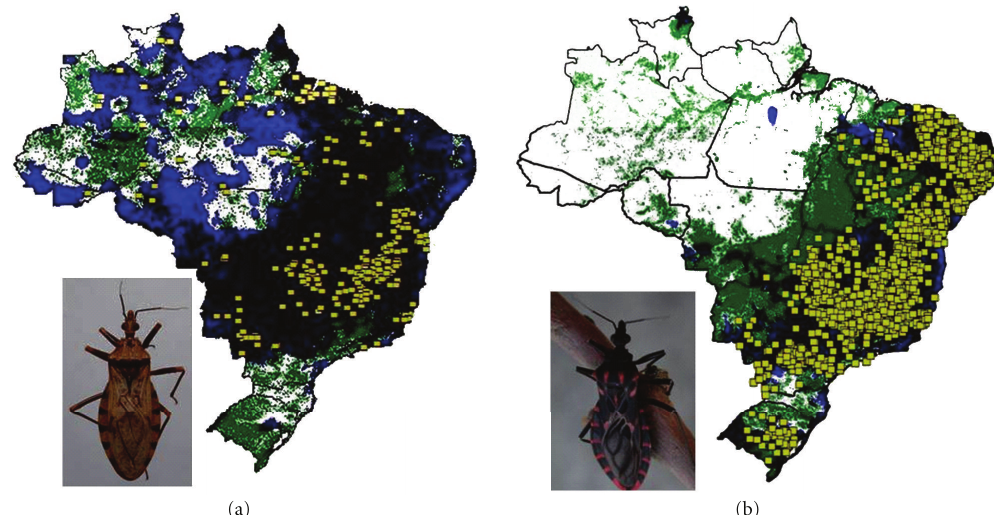
Figure 2: Ecological niche models projected as potential distributions for triatomine species with widespread distribution in Brazil. (a) Panstrongylus geniculatus and (b) P. megistus . Known occurrences of the species are shown as yellow squares, and the final consensus prediction is shown as black shading. Areas identified as suitable based on climatic grounds only are shown in blue, whereas areas identified as suitable based on normalized di ff erence vegetation index (NDVI) only are shown in green.